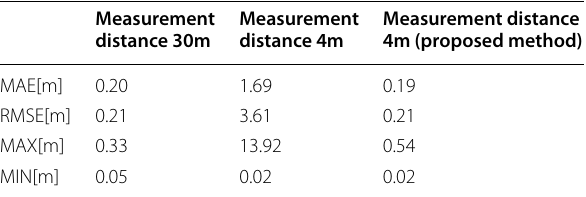
Table 3 Simulation results for dealing with degeneracy in the direction of